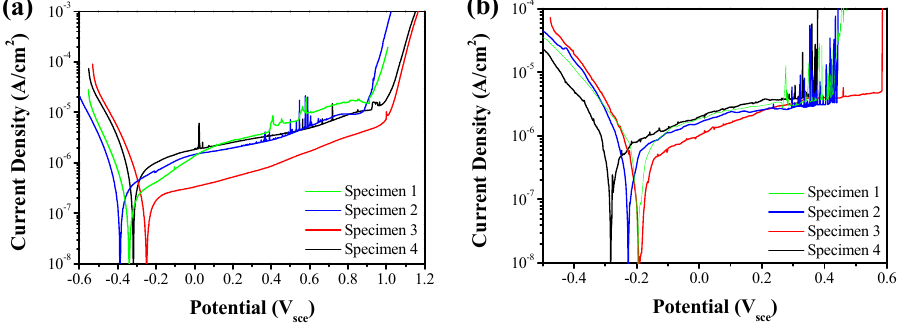
Figure 11. The polarization curves of fusion zones of the as-weld specimens: ( a ) 30 °C; ( b ) 50 °C.